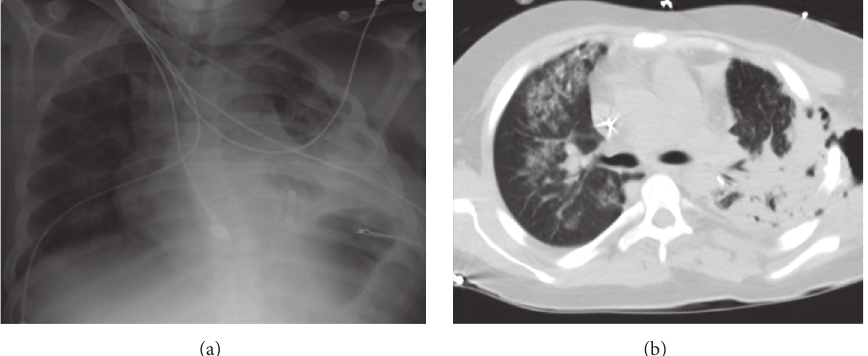
Figure 4: 18-year-old male renal transplant recipient 24 days status after resection of left lower lobe for a fungating mass with (a) chest X-ray demonstrating left upper lobe consolidation and (b) chest computerized topography scan showing consolidation of right upper, middle, and lower